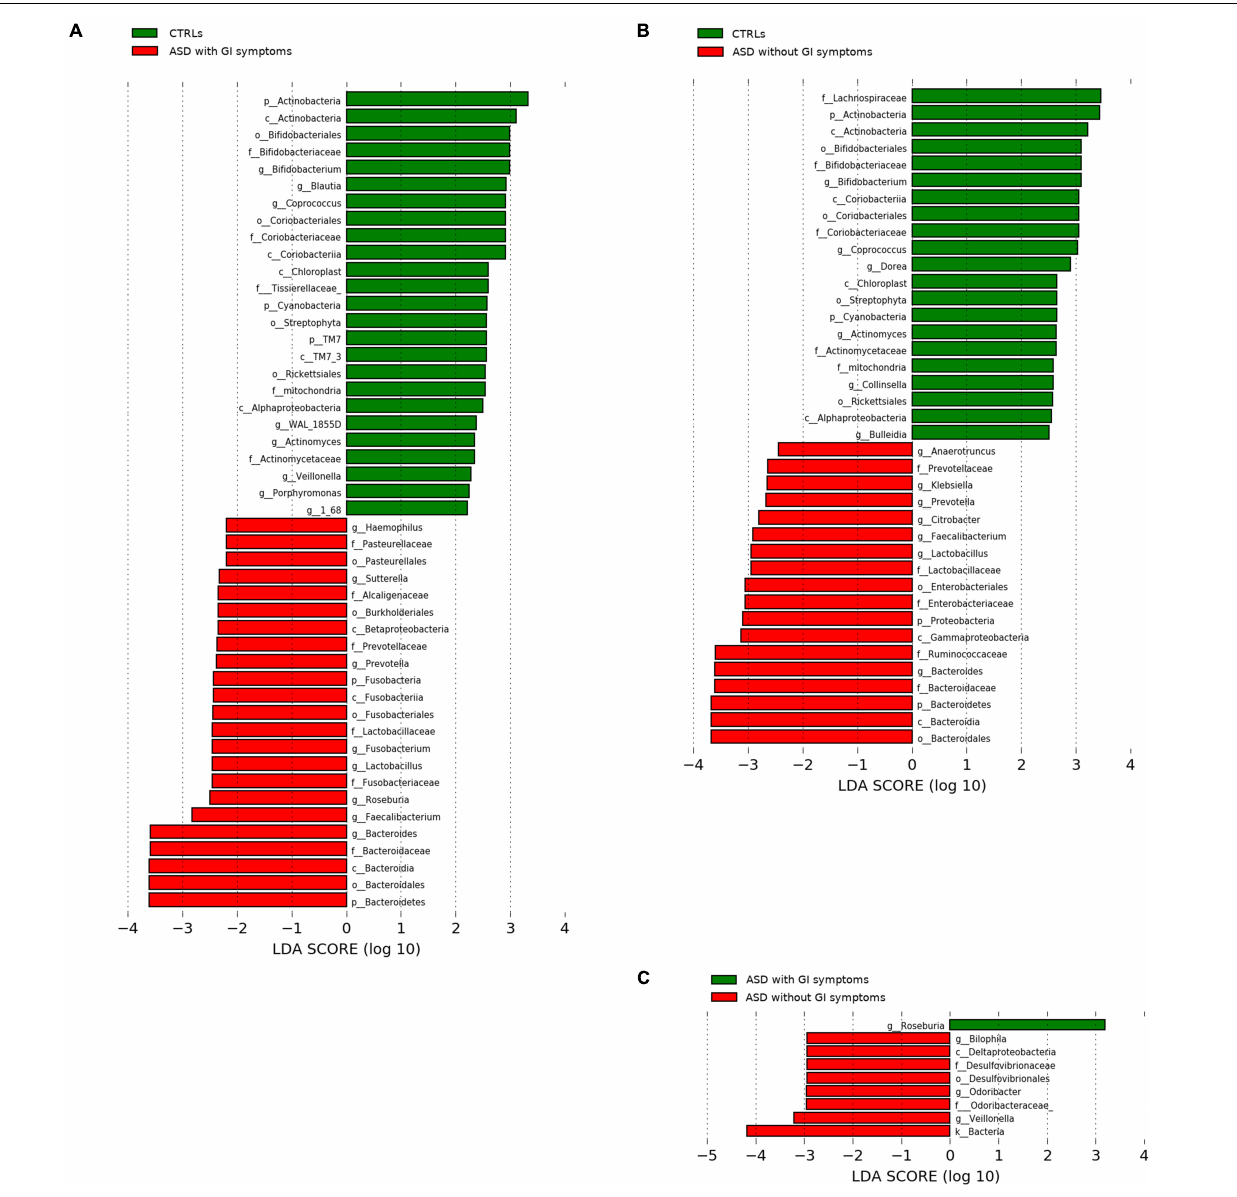
FIGURE 6 | LEfSe analysis between the patients with ASD grouped for presence of GI (with GI) or GI absence (without GI) and CTRLs cohorts. Histogram represents the LDA scores of bacteria (L6) with statistically significant differential abundance between groups. (A) CTRLs versus ASD with GI symptoms; (B) CTRLs versus ASD without GI symptoms; (C) ASD with GI versus ASD without GI symptoms. In red, ASD; green, CTRLs. All OTUs reported were statistically significant ( p -value ≤ 0.05).